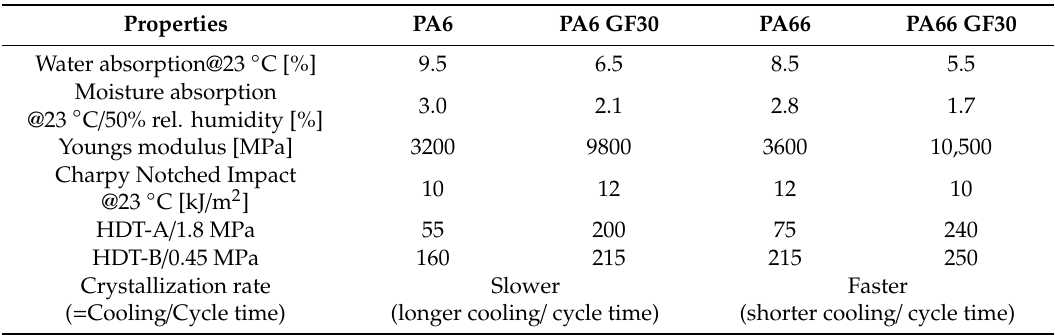
Table A1. Property overview of non-reinforced and 30 wt% glass fiber (GF) reinforced polyamide 6 (PA6) and PA66. Reproduced from [61].